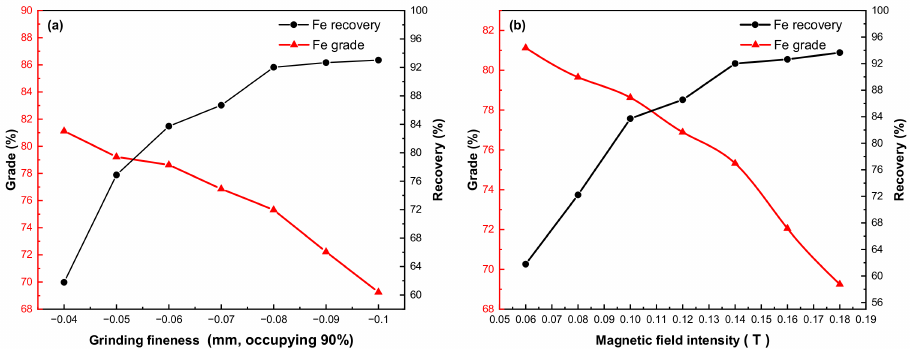
Figure 6. Effect of grinding fineness ( a ) and magnetic field intensity ( b ) on iron